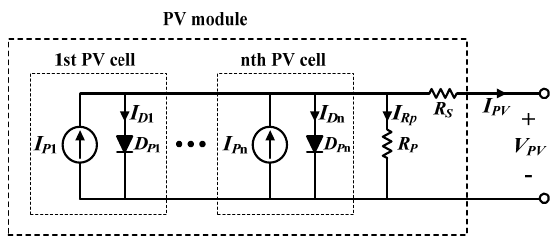
Figure 6. Equivalent circuit of the PV module.